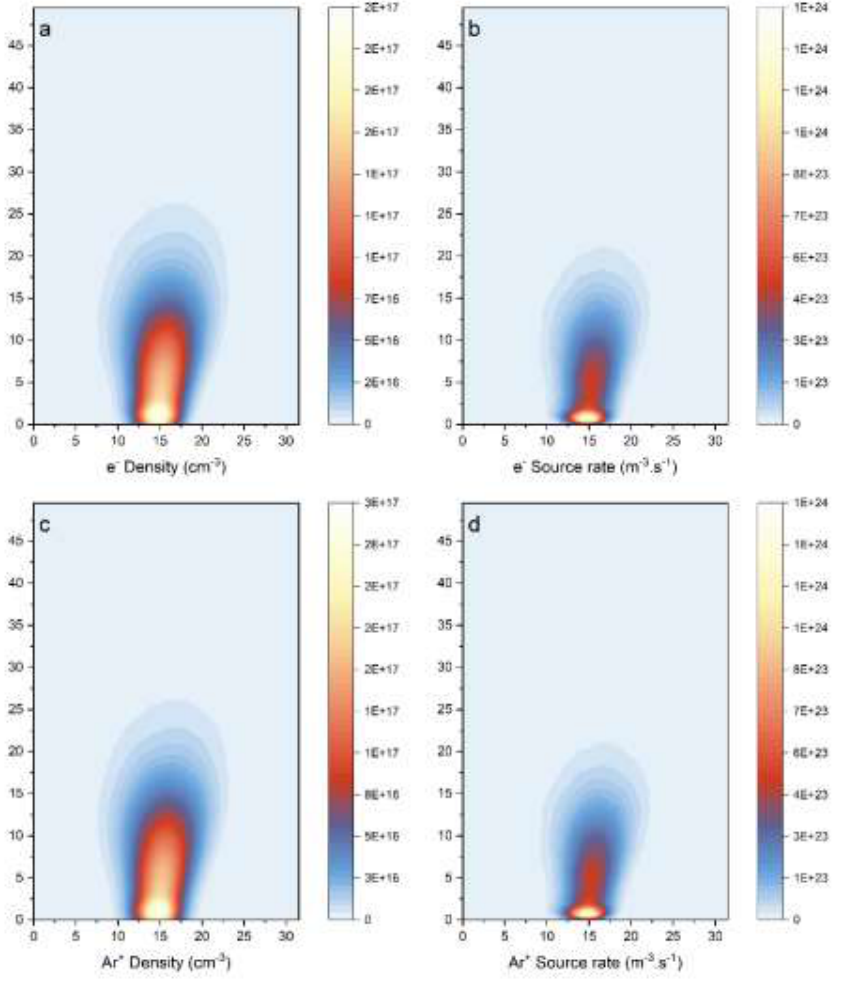
Figure 3: a) 2D simulation of the distribution of the e- density in the vacuum chamber. b) the generation rate of the electrons at the surface of the target. c) ion density distribution and b. the generation rate of the argon ions at the target surface. All y- and x- axes are in